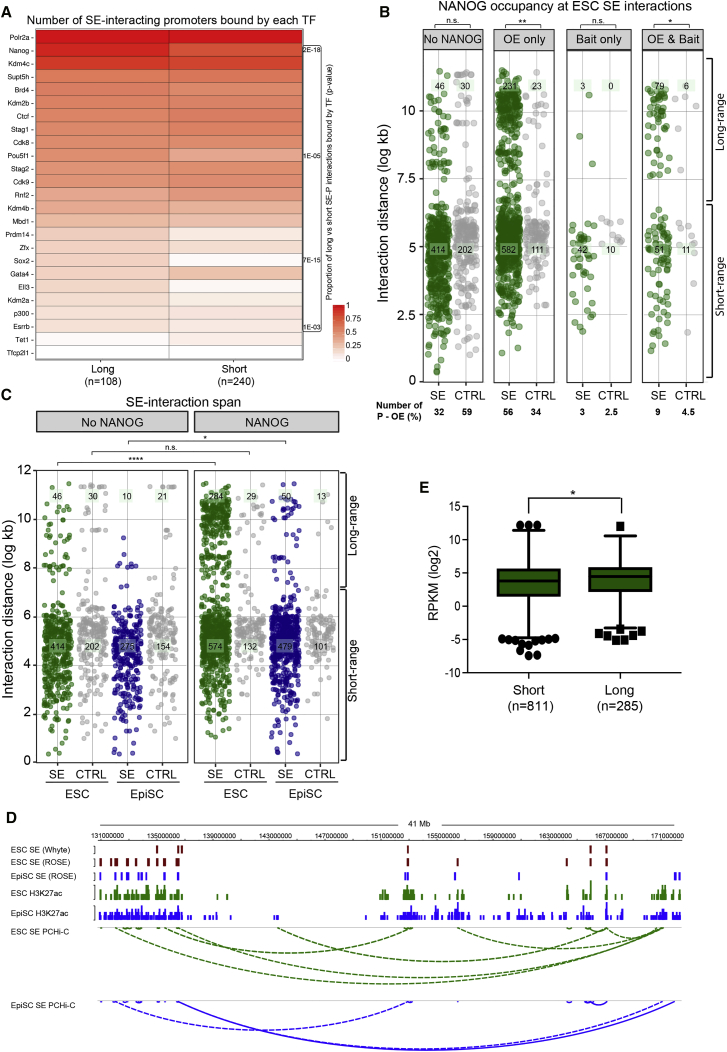
Long-Range Promoter-SE Interactions Are Enriched for NANOG Binding(A) CODEX database was integrated to screen for the binding of transcription factors (TFs) at the promoter of genes involved in long- and short-range SE interactions in ESCs. The heatmap shows the top 25 TFs bound at promoters engaged in LRIs with SEs, normalized by column. The side panel shows the Benjamini-Hochberg adjusted chi-square p values for the proportion of long- versus short-range interactions bound/not bound by NANOG, POU5F1, SOX2, and ESRRB.(B) Either end of the promoter-SE/CTRL contacts was classified according to the binding of NANOG. The majority (68%) of promoter-SE interactions in ESCs were bound by NANOG, particularly at the SE end (56%). The percentage of interactions within each category is shown. OE, other end of interaction (either SE or matched control). ∗∗p < 0.01; ∗p < 0.05 (Mann Whitney U test).(C) LRIs were significantly enriched for NANOG occupancy when compared to short-range (<800 kb) interactions in ESCs (green dots, Benjamini-Hochberg adjusted chi-square p = 2E-18; Figure S3A). This enrichment was moderately significant in EpiSCs (blue dots, Benjamini-Hochberg adjusted chi-square p = 8E-03) and not significant at control regions (gray dots).(D) Genome browser illustrating an example of LRIs between promoters and SEs in ESCs (green dashed arcs) and in EpiSCs (blue dashed arcs).(E) Gene expression levels (log2 RPKM) of genes engaged in long- and short-range SE interactions in ESCs (Mann-Whitney U test; p = 0.01).See also Figure S3 and Tables S2 and S3.